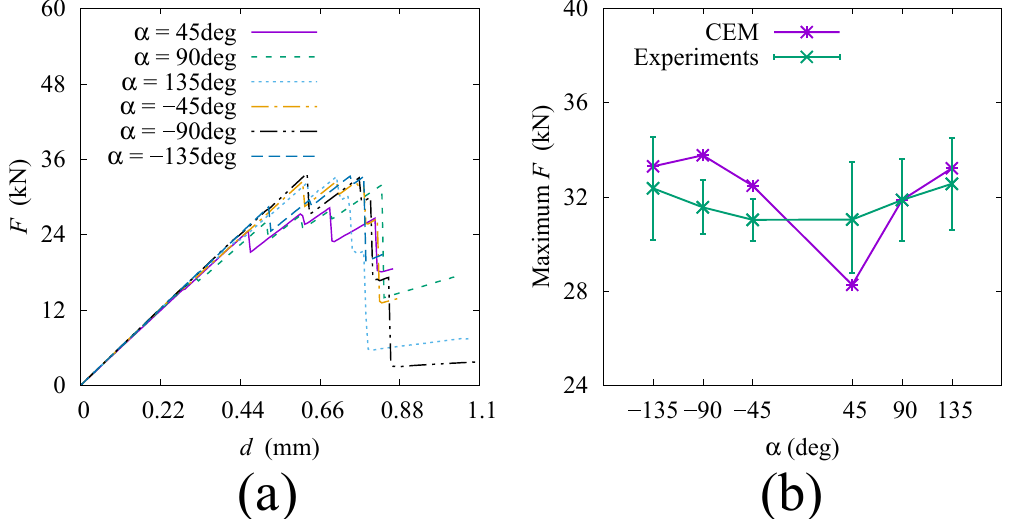
Figure 12. 3D-printed materials with two intermittent fissures: ( a ) force–displacement curves and ( b ) maximum vertical loads compared to the experimental results provided in [84].